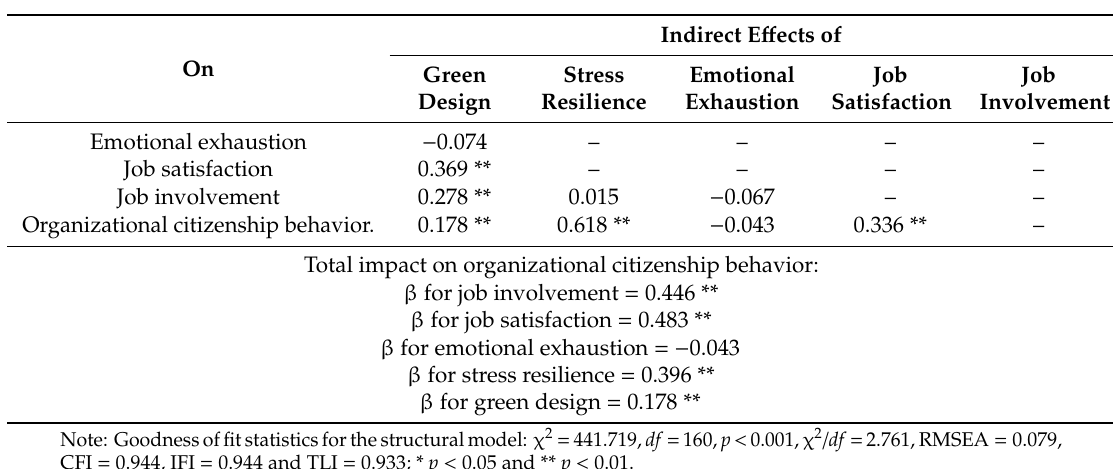
Table 3. Indirect impact and total impact assessment ( n =